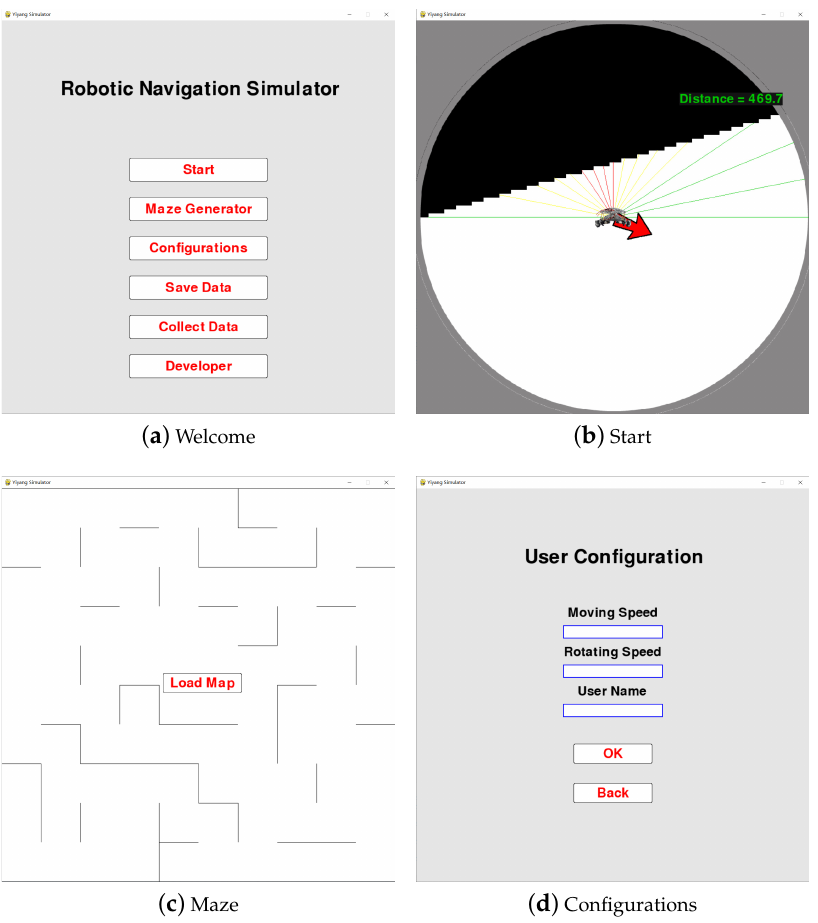
Figure 1. RoNAP provides several visual interfaces for user operation. Subfigure ( a ) shows the initial interface, with six functions for robot navigation analysis available by clicking on corresponding button. Subfigure ( b ) shows the start interface, where scene information within the detectable range of the laser can be observed. Subfigure ( c ) shows the maze interface, where a new scene with random obstacles is generated and loaded as a picture. Subfigure ( d ) shows the user configuration interface, where movement speed, rotation speed, and user name can be